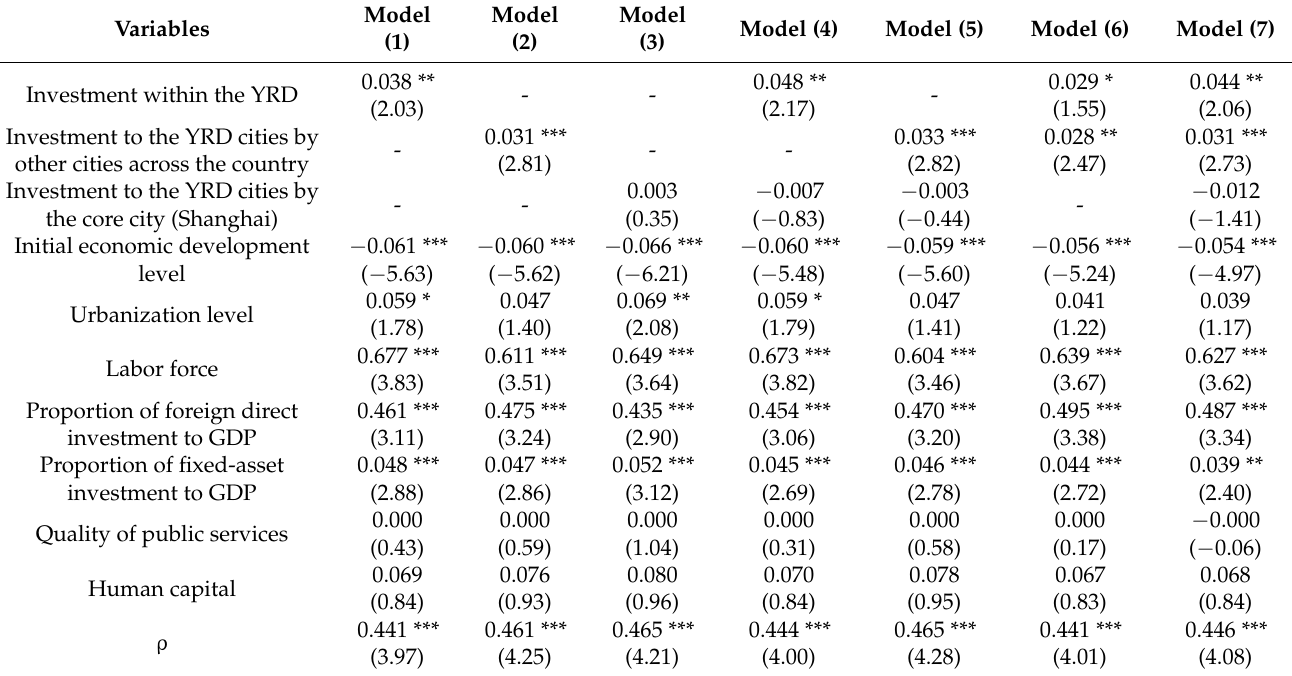
Table 3. The spatial econometric results of GDP growth